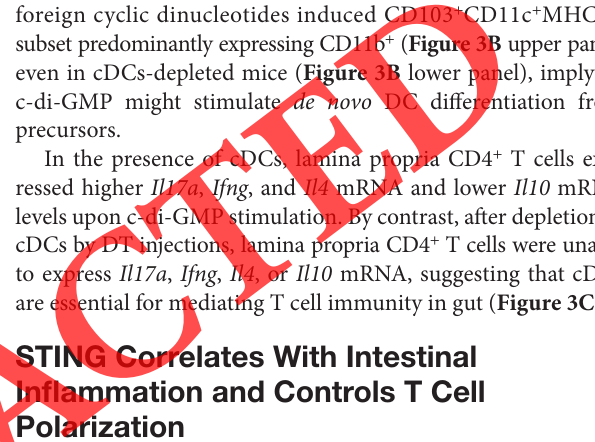
FigUre 1 | Mucosal classical dendritic cells (cDCs) express CD103 and elicit Th17 responses. (a) Co-expression of CD103 and Zbtb46 on CD11c + MHCII + DCs in SILP. (B) Zbtb46, B220, and CD11b expression on CD11c hi CD103 + (G1) and CD11c int CD103 − cells (G2) in SILP. Representative of three independent experiments ( n = 5). (c) IL-17A production during antigen-specific T cell activation by cDCs. CD11c + MHCII + CD103 + cDCs were isolated from either small intestinal lamina propria, spleen, or MLN, and were cocultured with splenic CD4 + CD62L + CD44 − naïve T cells from OT-II transgenic mice in the presence of OVA for 3 days in vitro . Representative of three independent experiments ( n = 4). (D) IL-17A, IL-10, IFN- γ , and IL-4 production during antigen-specific T cell activation by cDCs upon the activation of stimulator of interferon genes (STING) agonist. cDCs were isolated from SILP and were transfected using Lipofectamine with c-di-GMP followed by coculture with splenic CD4 + CD62L + CD44 − naïve T cells from OT-II transgenic mice in the presence of OVA for 3 days in vitro . Representative of three independent experiments ( n = 5). (e) IL-17A production during antigen-specific T cell activation by cDCs or pDCs upon the activation of STING agonist. Cells were prepared as described in panel (D) . Representative of three independent experiments ( n = 5). (F) IL-17A and IL-10 production during antigen-specific T cell activation by CD103 + cDCs. Cells were prepared as described in panel (D) and were incubated with anti-IL-6, recombinant IL-6, anti-IL-1 β , and recombinant IL-1 β in the presence of OVA for 3 days in vitro . Representative of three independent experiments ( n = 5). (g) STING production in spleen and colon tissue of WT and Tmem173 − / − ( − / − ) mice. (h) Fold change of Il6 , Ifnb1 , Tnf , Il1b , Il10 , Il23a , and Tgfb1 gene expression in cDCs of Tmem173 − / − mice in response to STING activation. C57BL/6 and Tmem173 − / − mice were injected (i.p.) with PBS or c-di-GMP at days − 1, − 3, and − 5, and cDCs were then isolated from SILP ( n = 4). (i) IL-17A, IL-10, IFN- γ , and IL-4 production during antigen-specific T cell activation by cDCs upon the stimulation of STING. cDCs were isolated from SILP of C57BL/6 or Tmem173 − / − mice and transfected with c-di-GMP followed by coculture with splenic CD4 + CD62L + CD44 − naïve T cells from OT-II transgenic mice in the presence of OVA for 3 days in vitro ( n = 4). Abbreviations: SILP, small intestine lamina propria; MLN, mesenteric lymph node; ND, not detectable; pDC, plasmacytoid